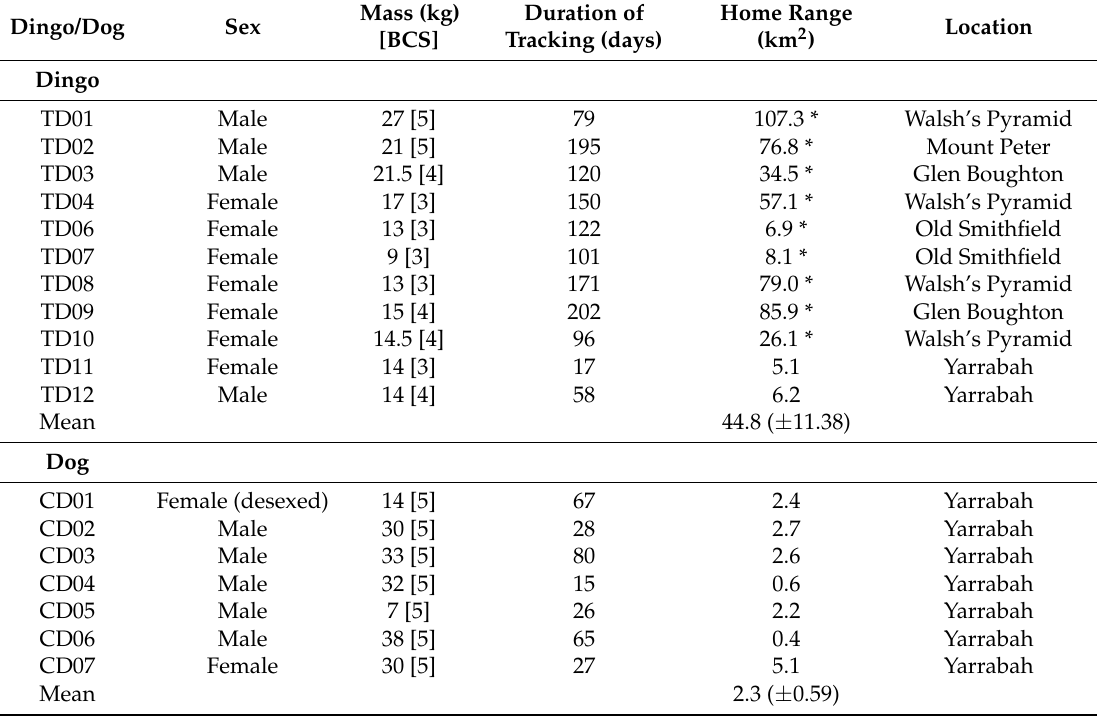
* Data from concurrent study